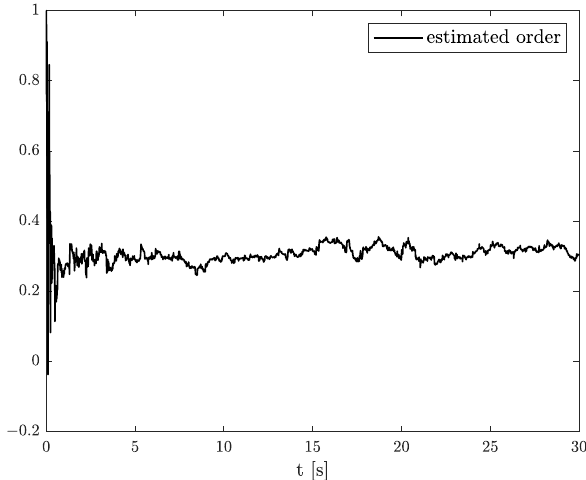
Figure 16. Order estimation for y -axis noise.